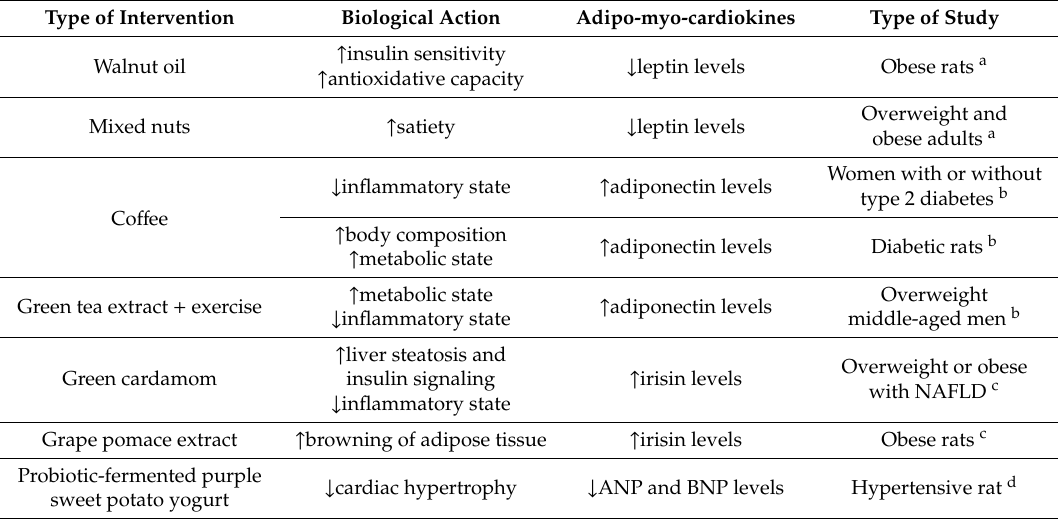
Table 5. E ff ects of function foods on adipokines, myokines, and cardiokines. Type of